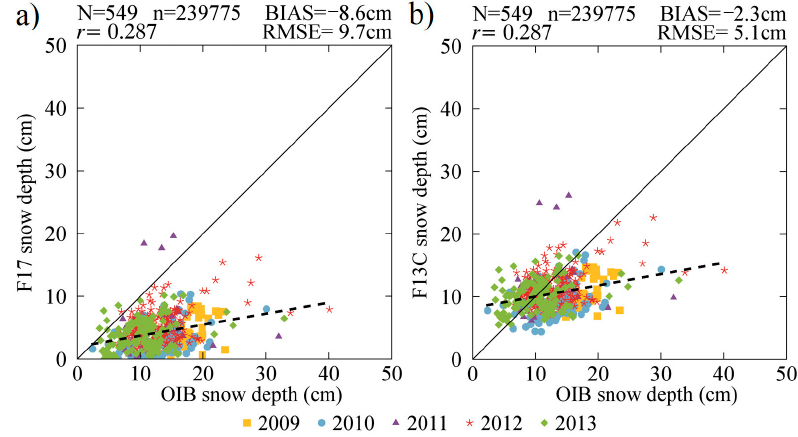
Figure 4. Comparison between satellites derived SD and OIB measured SD: ( a ) F17 snow depth vs. OIB snow depth; ( b ) F13C snow depth vs. OIB snow depth. F13C snow depths are derived from F13C